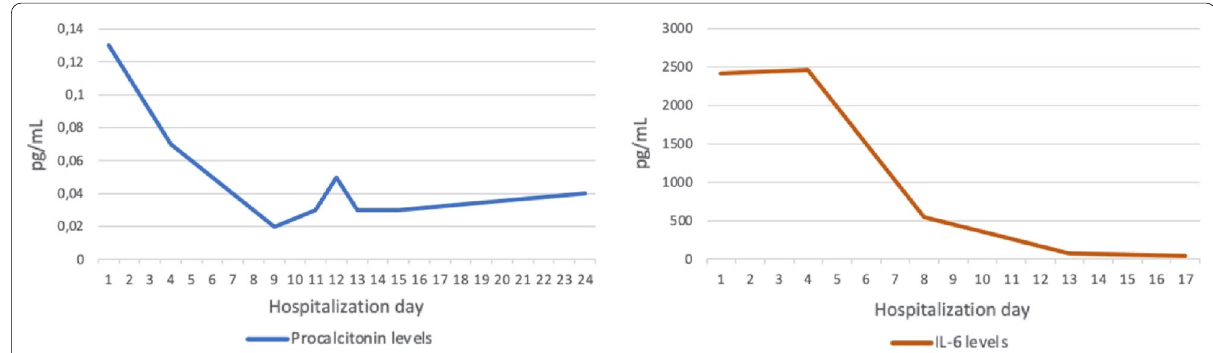
Fig. 2 Inflammatory markers trend during